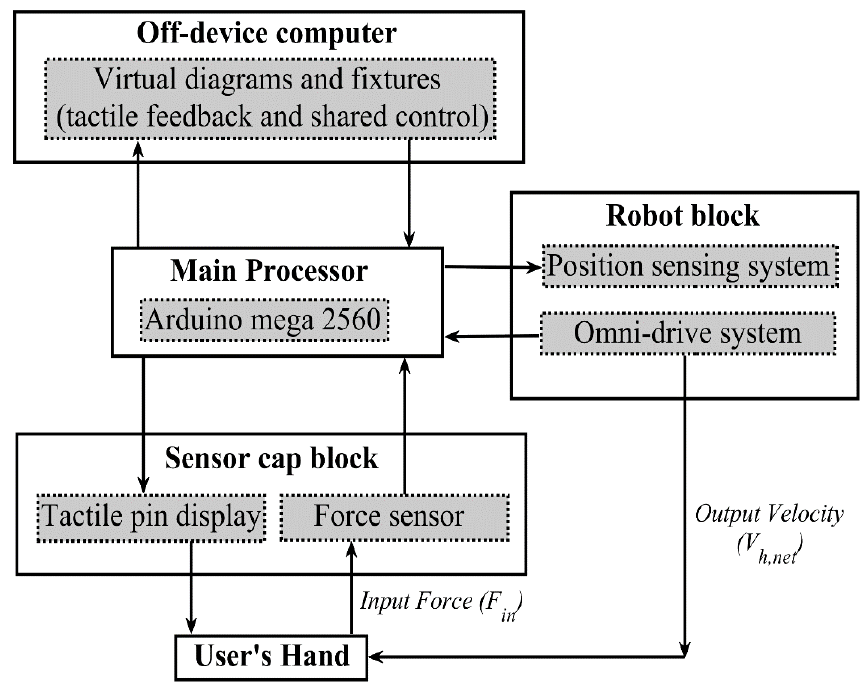
Figure 1. Block diagram illustrating the interaction between functional blocks of the system.